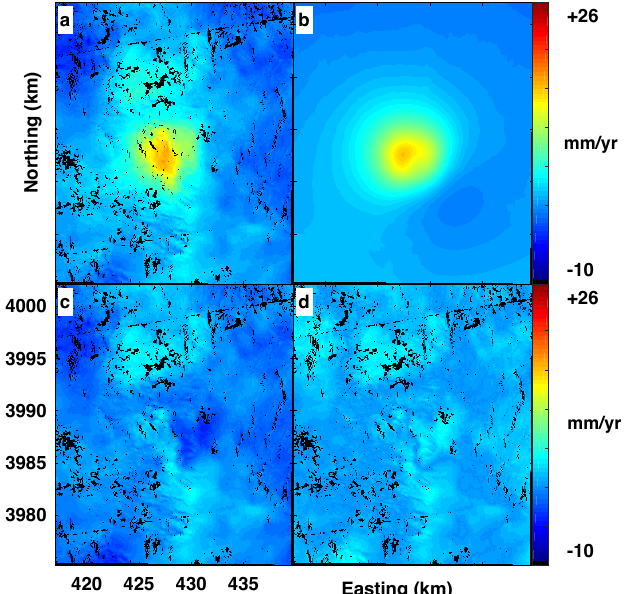
Figure 9. Deformation fields in terms of (unwrapped) range change rates from the minimum spanning tree (MST) Envisat stack spanning November 14, 2003 to September 3, 2010 analyzed using nonlinear inversion methods outlined in Feigl and Thurber [39]. The estimate of the parameter vector was based on finite element models by Ali et al. [27]. Inversion was performed using unwrapped range change rates. Results are shown in terms of unwrapped range change rate: ( a ) Observed range change rate, ( b ) modeled range change rate, ( c ) residual between observed and modeled, and ( d ) absolute value of residuals. We use the Universe Transverse Mercator (UTM) coordinate system as in Figure 1.